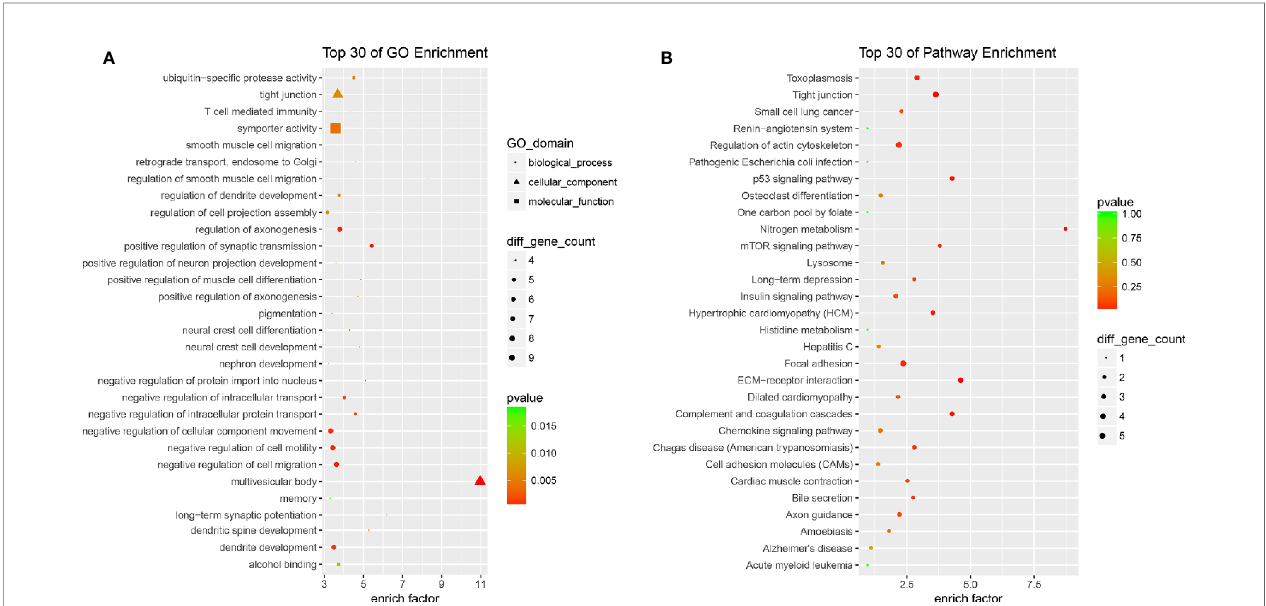
FIGURE 5 | Bioinformatics analysis of differentially expressed (DE) mRNAs. (A) Top 30 of Gene Ontology (GO) enrichment of quercetin vs ox-LDL. (B) Top 30 of KEGG enrichment of quercetin vs